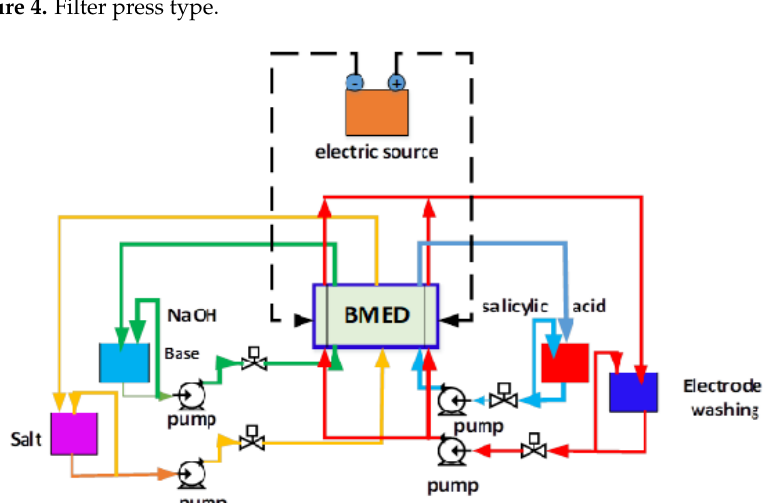
Figure 4. Filter press type.